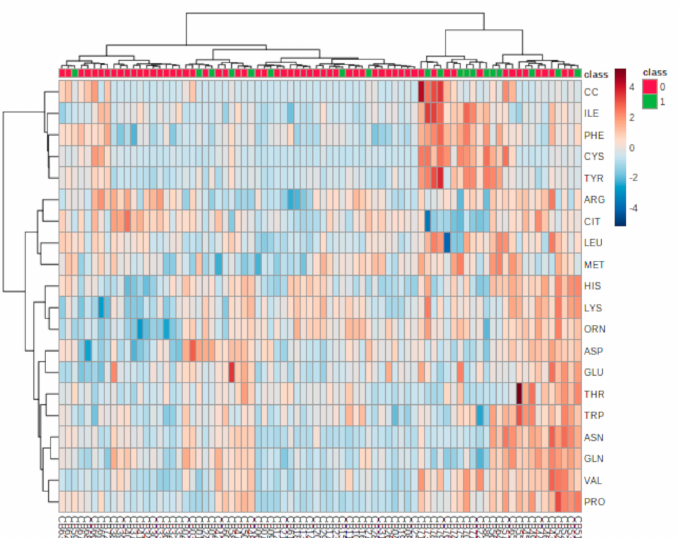
Figure 3. Heatmap of targeted metabolomic analysis for the correlation between analyzed amino acids and individual samples. Rows, amino acids; columns, individual samples. Color key shows the metabolite expression value: lowest (blue) and highest (red); 0 refers to lower oxidative stress (Q1–Q3 nitrotyrosine) group; 1 refers to highest oxidative stress (Q4 nitrotyrosine)